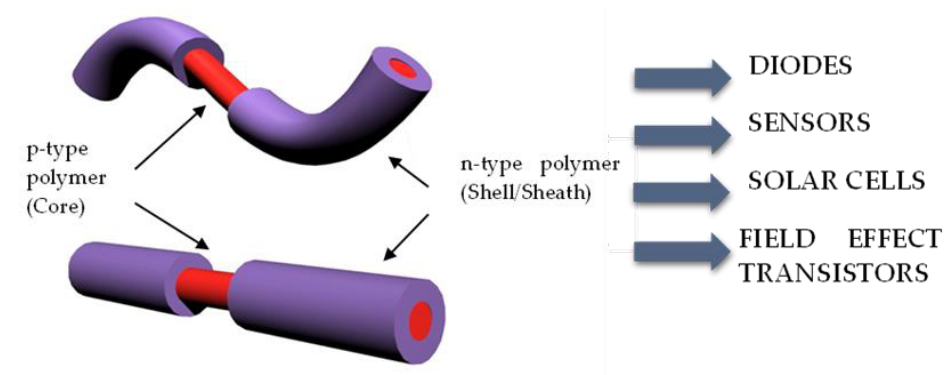
Figure 2. Coaxial nanofiber with p- and n-type semiconducting polymers. This nanofiber provides an opportunity to form p – n junctions that can be tethered for electroactive textiles and single- nanofiber devices .